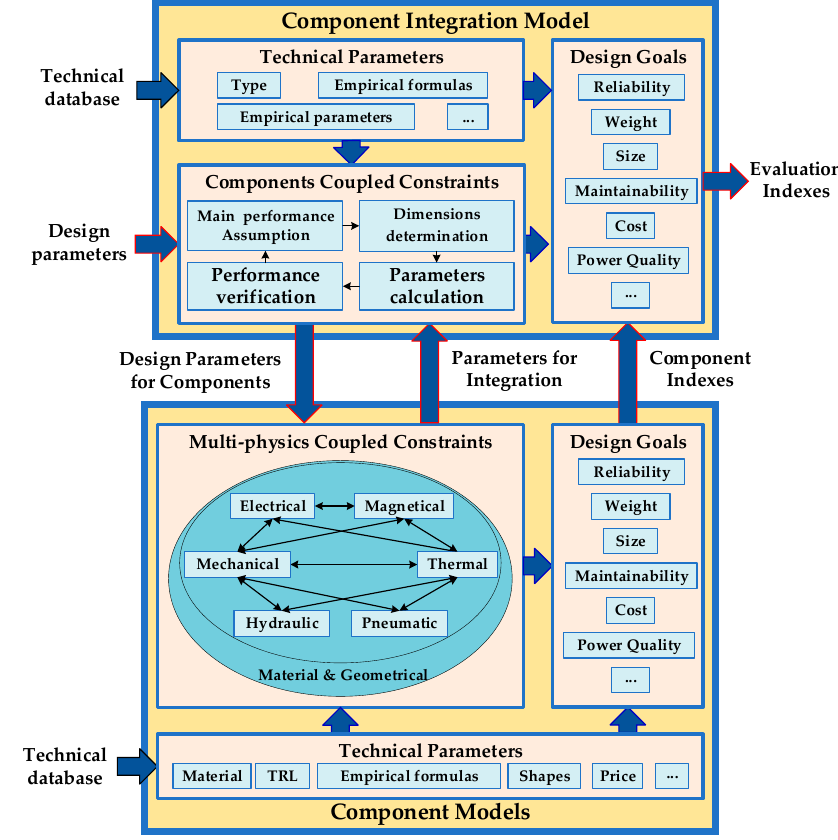
Figure 2. Multi-physics model of a machine.